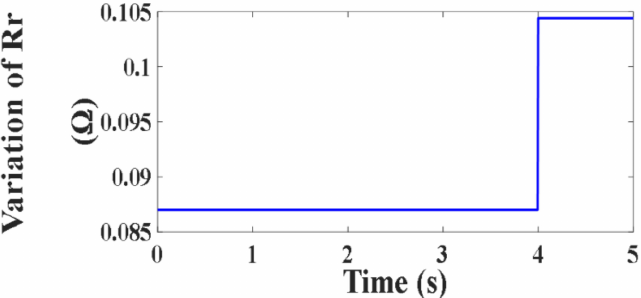
Figure 78. Variation of R r ( Ω ).